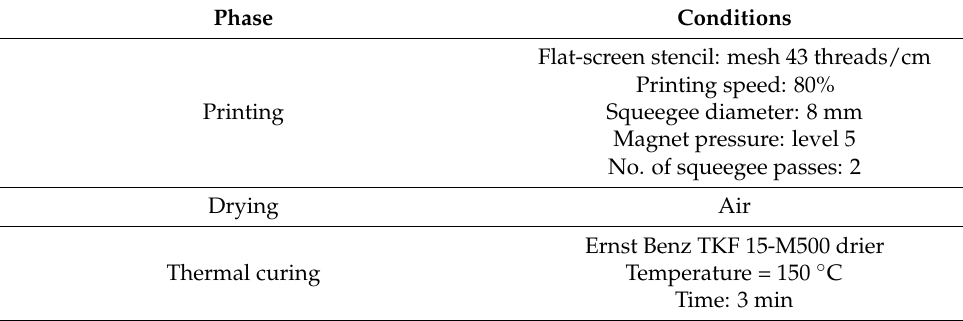
Figure 2. The printed samples: ( a ) fully printed, ( b ) printed according to patterns (dots with four diameters). Table 2. Printing, drying and curing